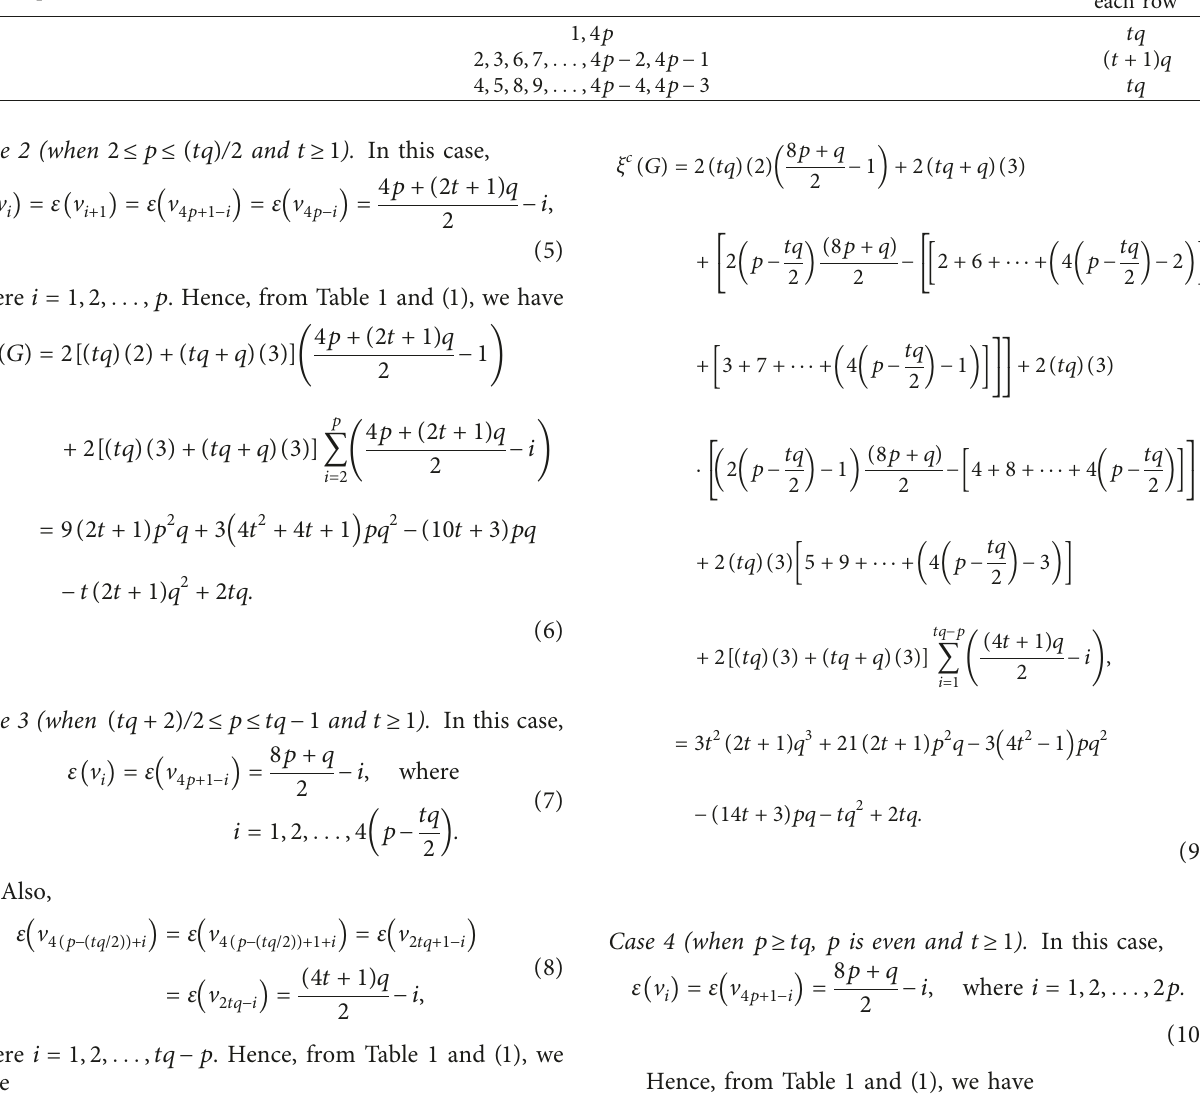
p,q nanotube along with their cardinalities corresponding to each row. [ ] , 4 p